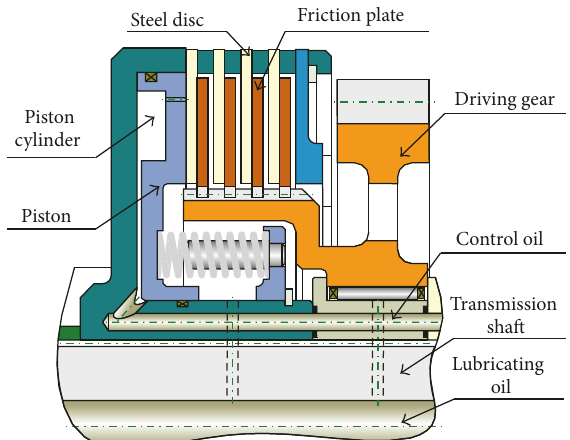
Figure 1: Structure diagram of wet multidisc clutch.